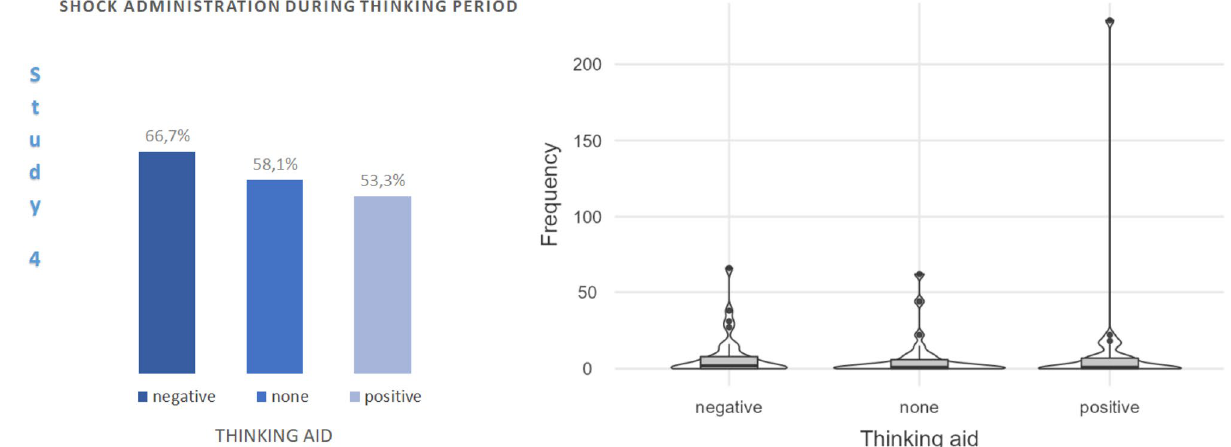
Figure 5. Self-administration of shocks in each thinking aid condition (left panel) and violin plot with box plots of the frequencies of self-administered shocks in each condition (right